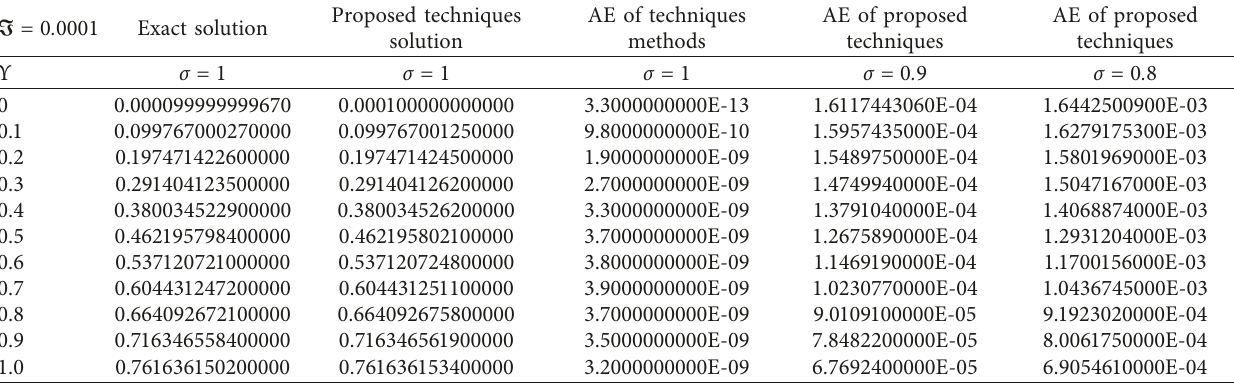
Table 4: Comparison of the proposed method and exact results with absolute error (AE) at various fractional order for ] ( ξ , I ) of problem 2. I � 0 . 0001